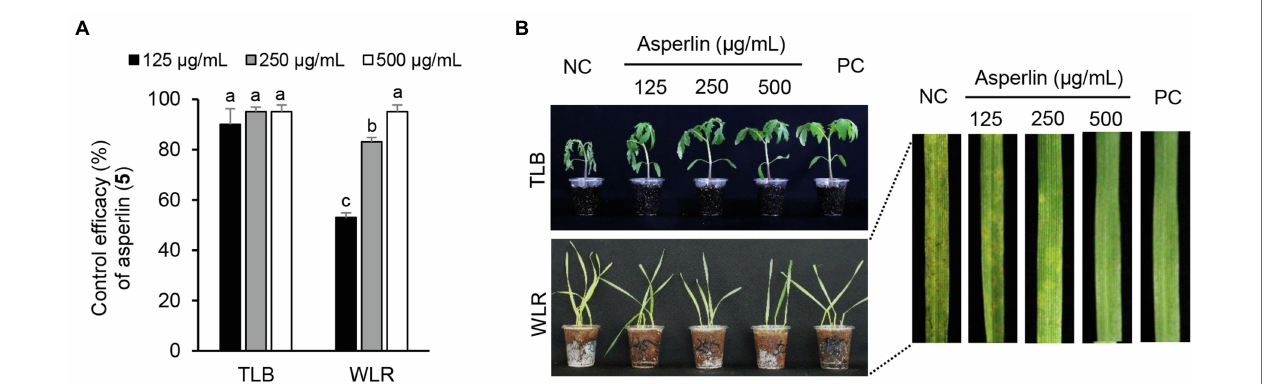
FIGURE 6 | Effects of asperlin ( 5 ) isolated from Aspergillus montenegroi SFC20200425-M27 on the development of tomato late blight (TLB) and wheat leaf rust (WLR) caused by Phytophthora infestans and Puccinia triticina . (A) Control efficacy of asperlin ( 5 ) against TLB and WLR. The bars represent the mean ± standard deviation of two runs with three replicates. Different small letters in each bar indicate a significant difference at p < 0.05 (Duncan’s multiple range test). (B) Representatives of plants treated with asperlin ( 5 ) at a concentration of 125, 250, and 500 μ g/ml. Plants were inoculated with sporangia or spores of P. infestans or P. triticina 1 day after treatment with asperlin ( 5 ). Treatment with Tween 20 solution containing 5% methanol and chemical fungicides (dimethomorph for TLB and flusilazole for WLR) were prepared as negative and positive controls (NC and PC),